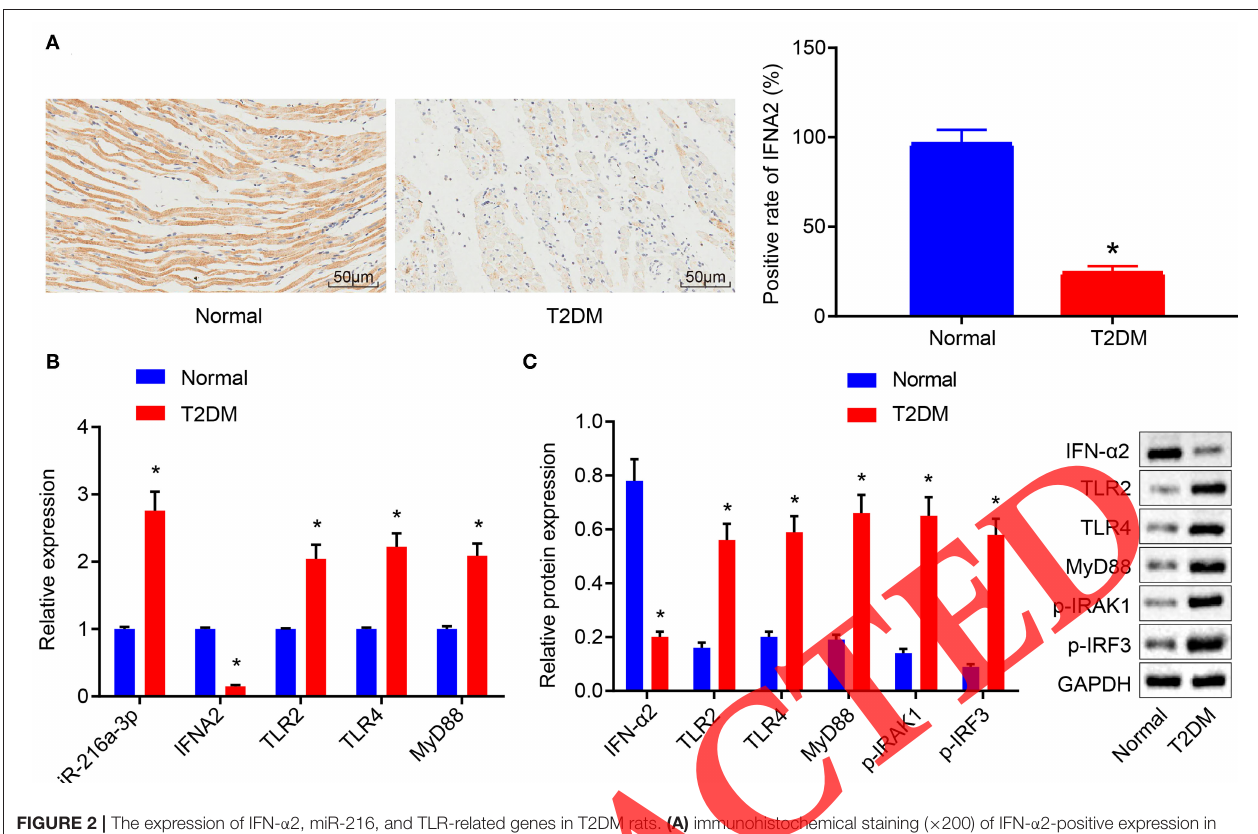
FIGURE 2 | The expression of IFN- α 2, miR-216, and TLR-related genes in T2DM rats. (A) immunohistochemical staining ( × 200) of IFN- α 2-positive expression in myocardial tissues of rats in the normal and T2DM groups; (B) mRNA expression of IFN- α 2, miR-216a-3p, and TLR pathway-related genes in the normal and T2DM groups using RT-qPCR; (C) protein expression of IFN- α 2 and TLR pathway-related genes in the normal and T2DM groups determined by Western blot analysis. * p < 0.05 vs. the normal group. The measurement data were presented by the mean ± standard deviation and analyzed using unpaired t -test. n =